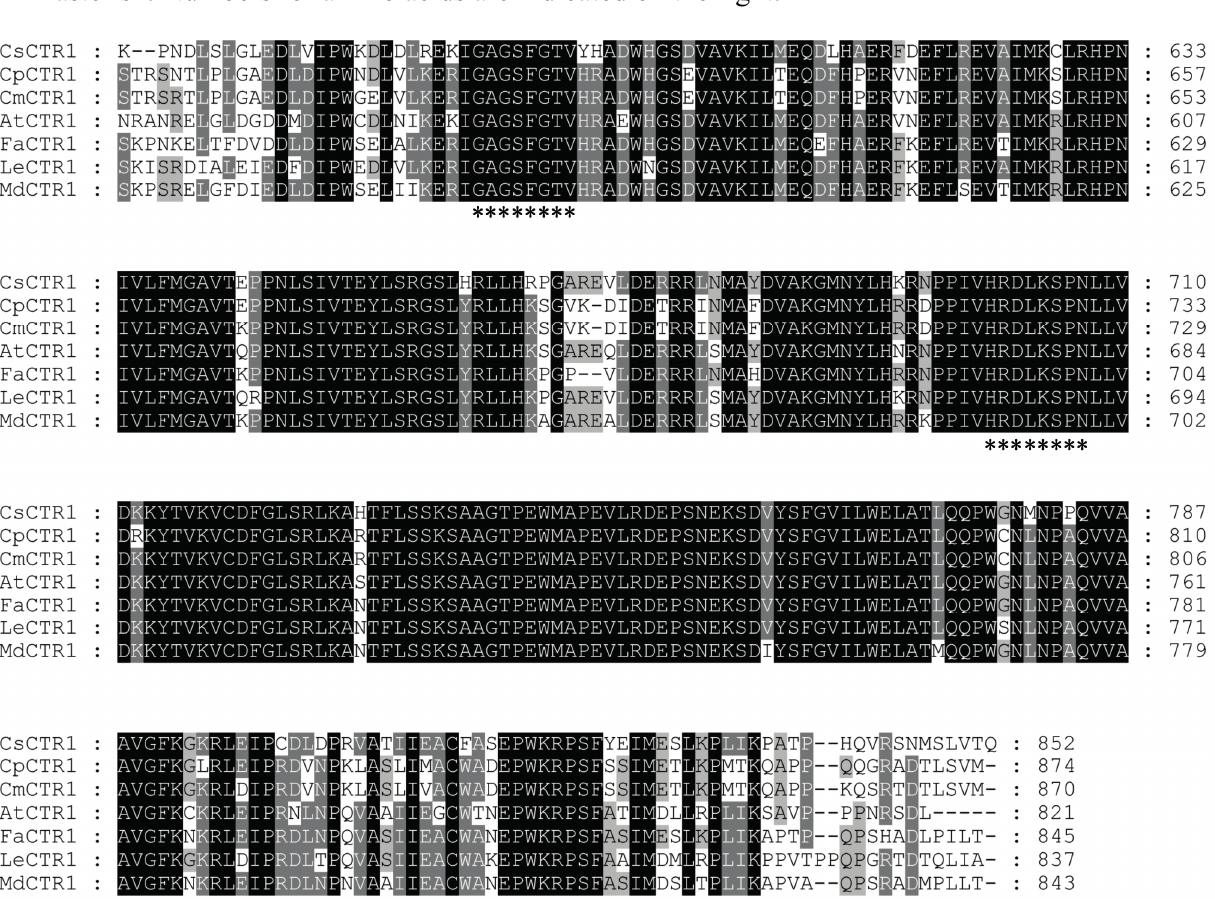
Figure 2. Multiple amino acid sequence alignments of the C -terminal Ser/Thr kinase domain in the CTR1-like proteins of several plant species. Seven genes from Malus × domestica (MdCTR1, ABI58290), Solanum lycopersicum (LeCTR1, AAL87456), Cucumis melo (CmCTR1, ADV92636), Cucurbita pepo (CpCTR1, ADB55631), Arabidopsis thaliana (AtCTR1, CAB82938), Fragaria × ananassa (FaCTR1, AFI38955) and Cucumis sativus (CsCTR1, AEZ53932) were used for multiple sequence alignment. Amino acids with identities of over 75% are shaded in black; whereas, those with identities ranging between 50% and 75% are shaded in gray. The ATP binding signature (GxGxxGxV) and the protein kinase active site consensus sequence (HRDLKxxN) are indicated by asterisk. Numbers for amino acids are indicated on the